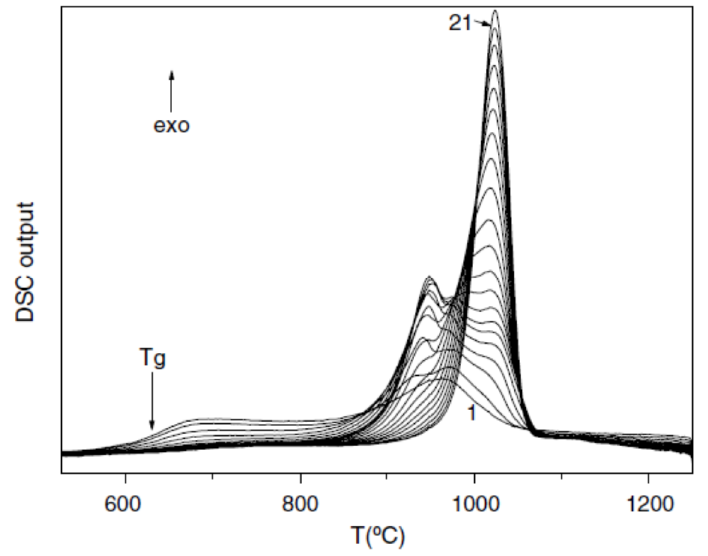
Figure 6. The repeated DSC down-scanning from 1250 °C (T n+ + 70°C). The numerals next to the graphs represent the order of the DSC down-scans. The measurements are performed in argon at the cooling rate 20 °C/min. Reprinted with permission from ref. [44], Copyright Elsevier.